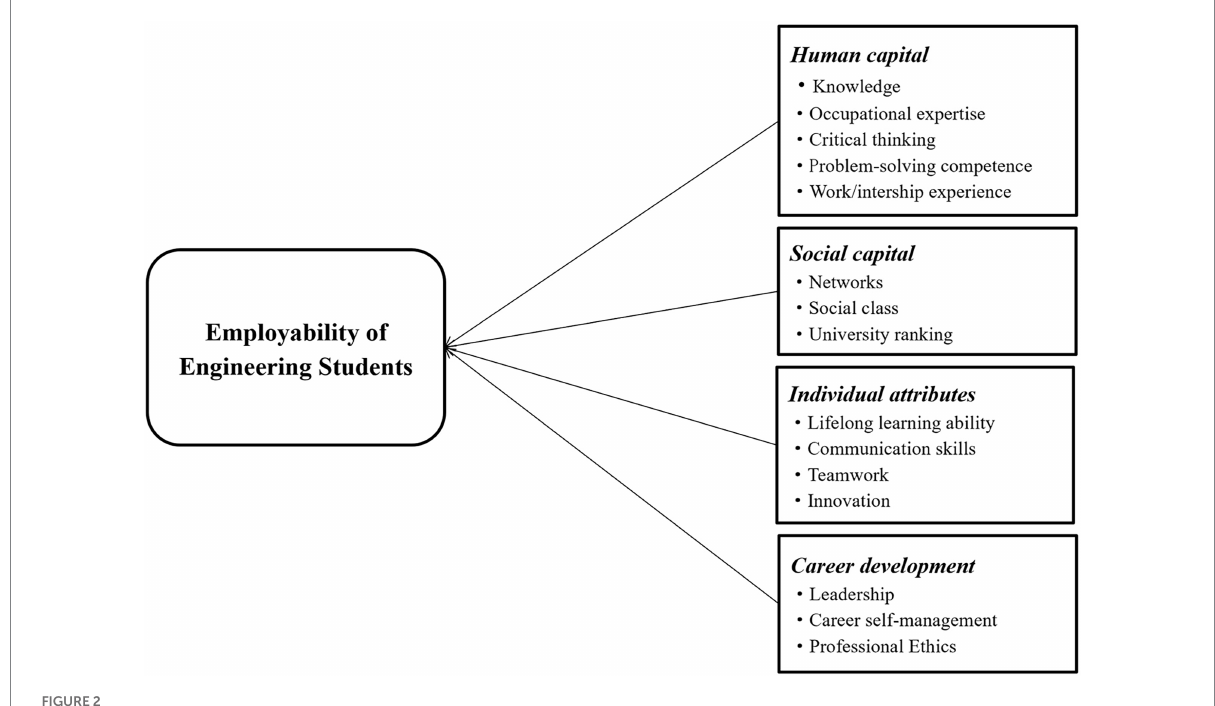
FIGURE 2 Core attributes of the employability of engineering